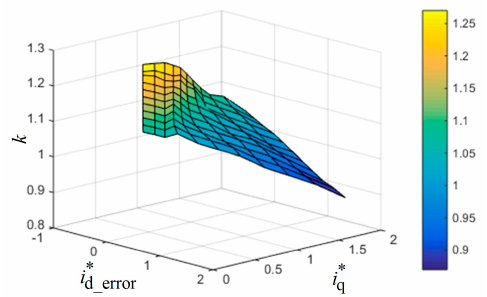
Figure 5. The 3D table of k varying with i * d.error and i q* .